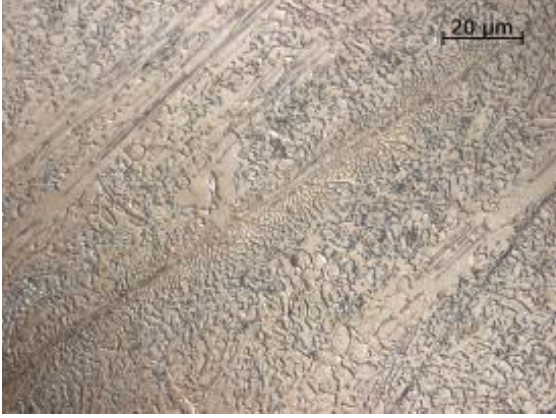
Figure 8. Microstructure of a nanocrystalline layer with eutectic like carbides of NANO (Fe-Cr-Nb-B).